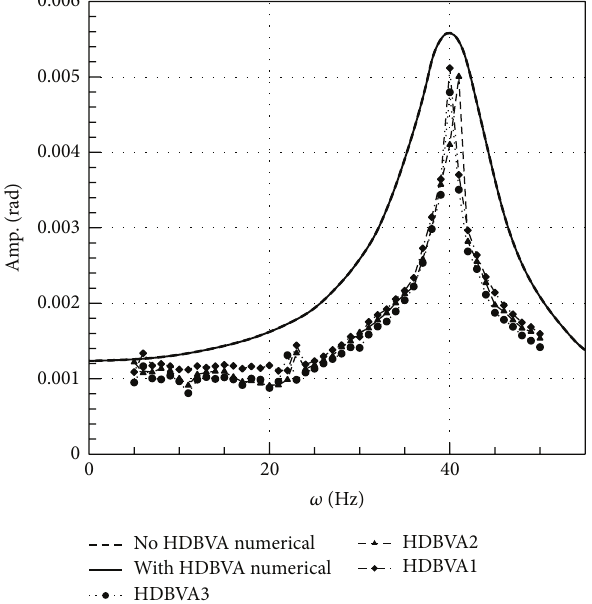
Figure 20: Frequency response of 𝜃 𝑋 DOF of case Figure 10(a), HDBVAs start at the near-force